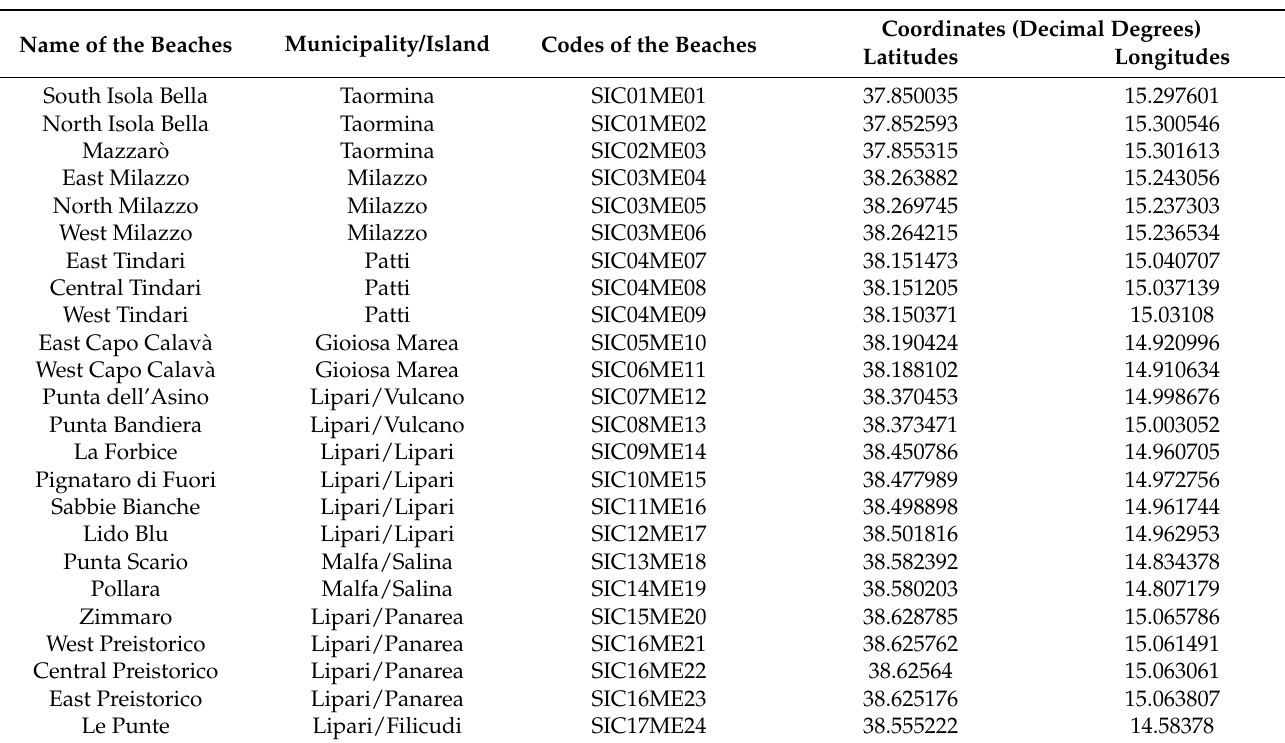
Table 4. Descriptions of 24 PBs of the province of